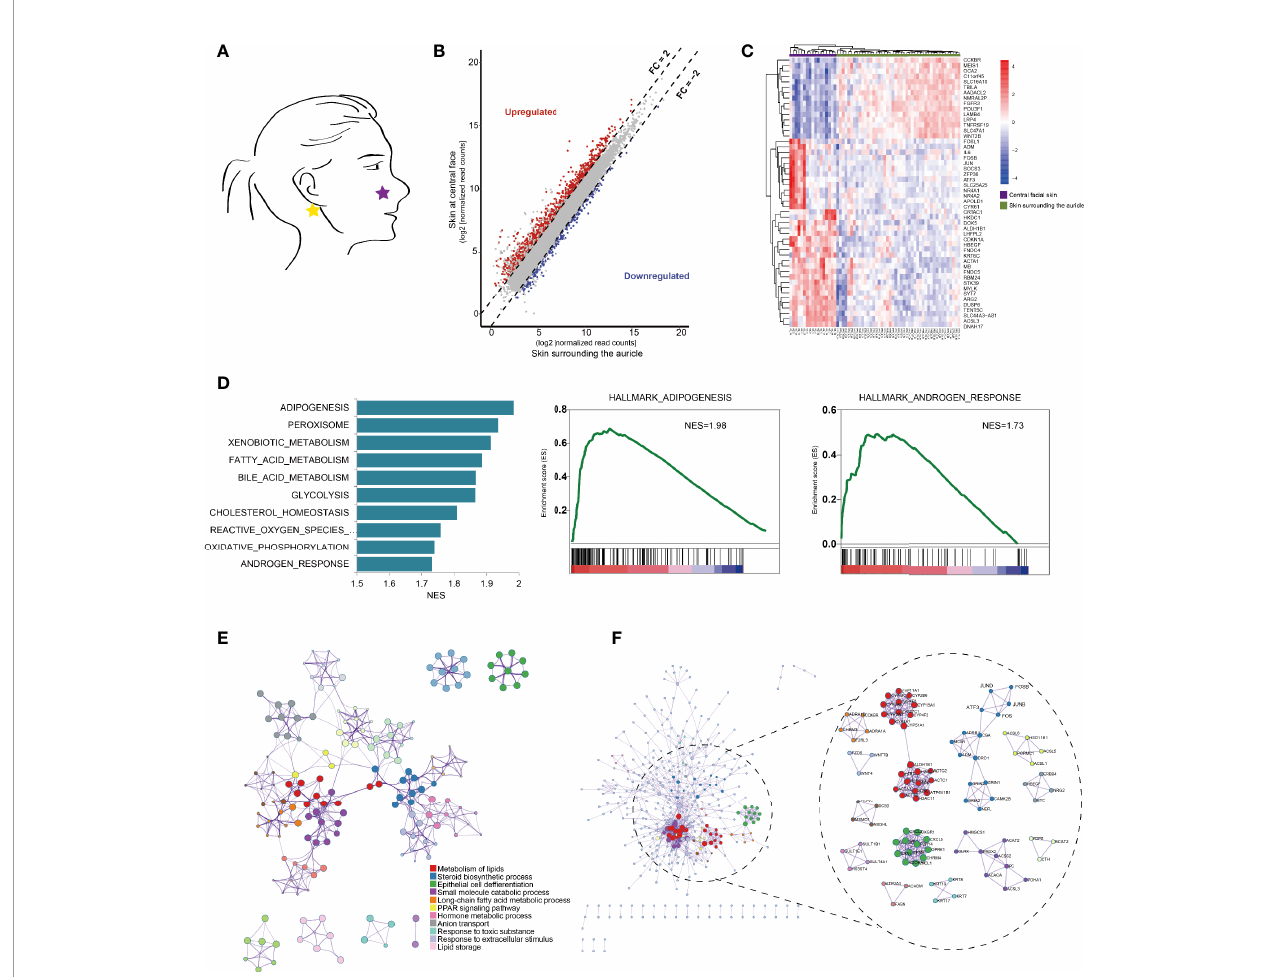
FIGURE 1 | Anatomical transcriptional pro fi ling in central facial skins. (A) Anatomic distribution of representative skin samples of central face tissue from healthy volunteers (N=17) and normal skin surrounding the auricle in rosacea patients (N=45). (B) Scatter plots comparing the expression of genes with fold change in expression > 2, false discovery rate (FDR) < 0.05 in central facial skin (purple bar) and normal skin surrounding the auricle (green bar). (C) Heatmap of the top 50 differentially expressed genes (DEGs) between central facial skin and skin surrounding the auricle. (D) Gene set enrichment analysis (GSEA) highlighting genes involved in adipogenesis, androgen and estrogen responses in central facial skin. NES, normalized enrichment score. (E) Metascape network analysis of enriched gene ontology (GO) terms and KEGG pathways for all DEGs, indicating crosstalk between the metabolism of lipid and steroid biosynthetic process in central facial skin. (F) The complex interactome network generated by Metascape, with the complexes colored according to identities. Highlights the expanded visualization of the complex and the AP1 pathway, including FOS, FOSB, JUNB, JUND and